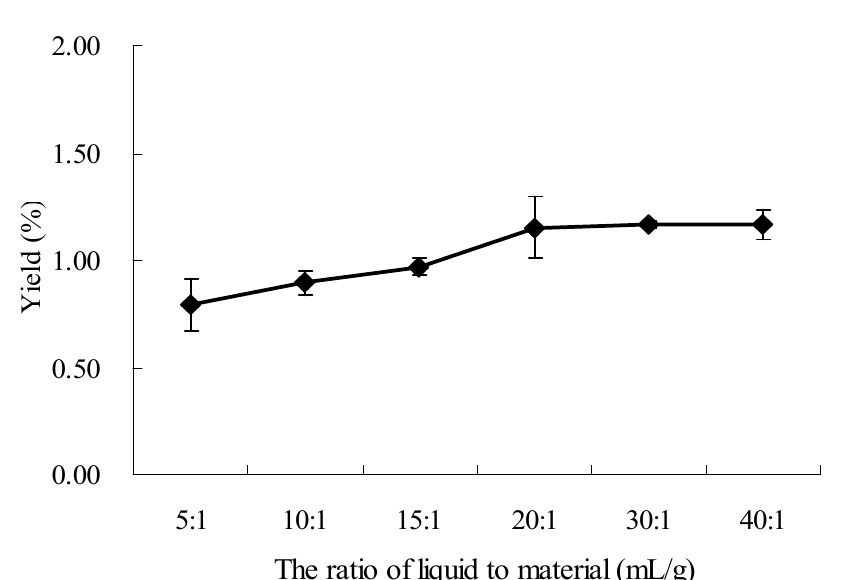
Figure 2. Effect of the ratio of liquid to material on the extraction